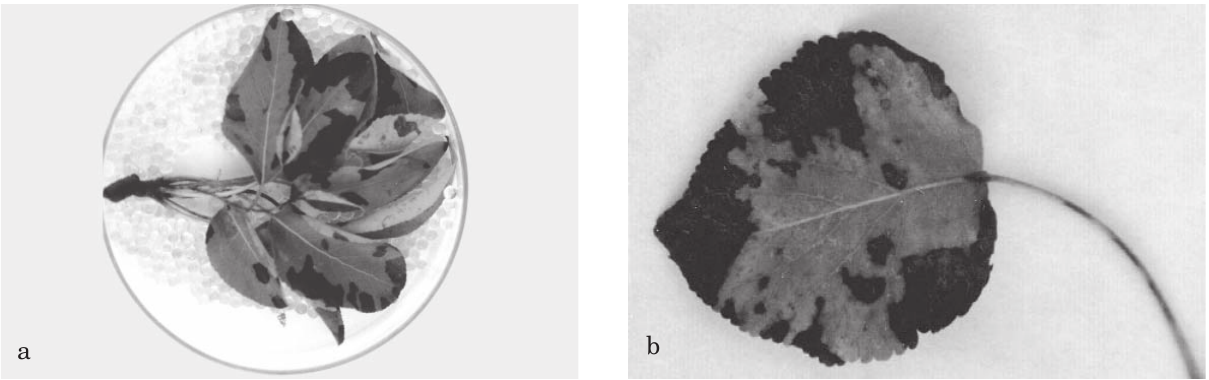
Fig. 3 (a, b). Symptoms in leaves of Pyrus mamorensis artificially inoculated by conidial suspension of Pestalotia